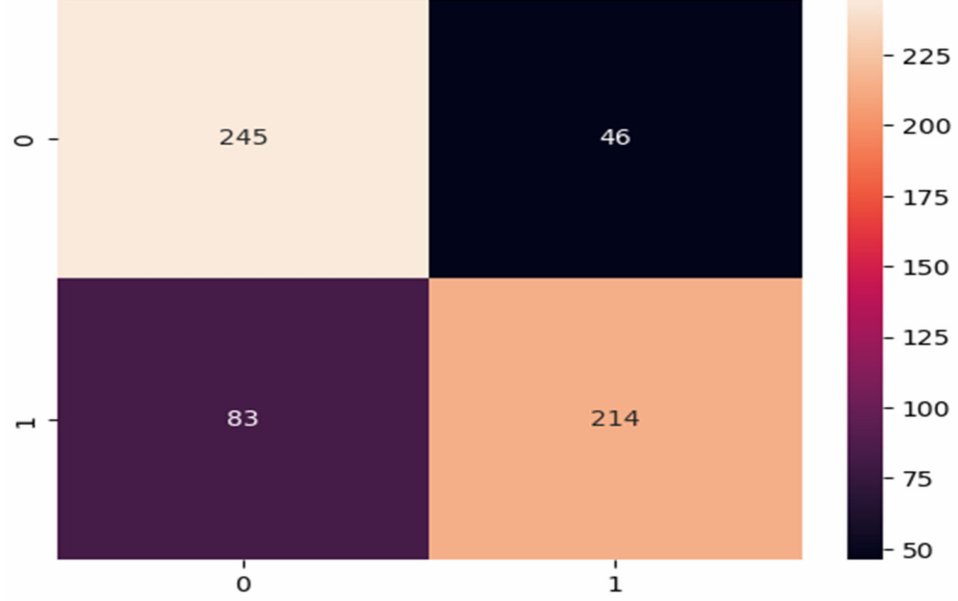
Figure 13. Confusion matrix of VGG-16 with random forest.